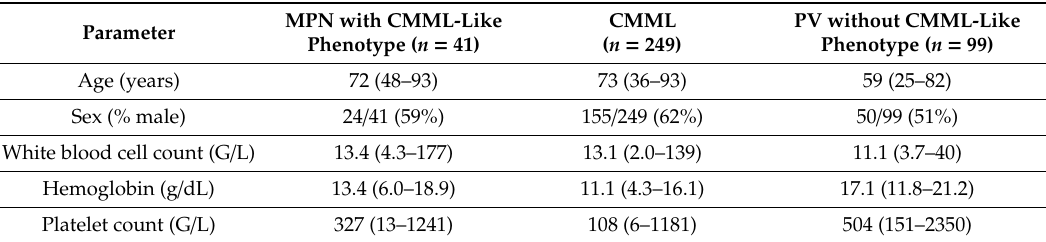
Table 1. Hematologic Phenotype in Myeloid Disorders.